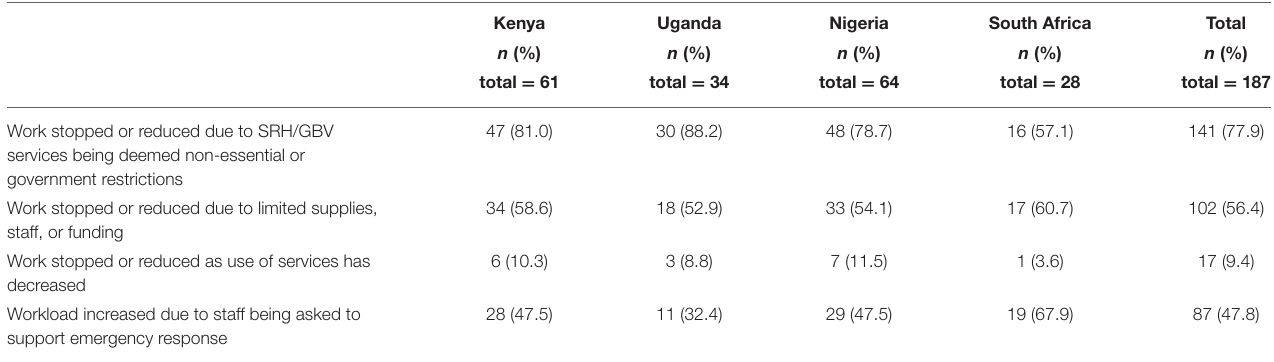
TABLE 2 | Effect of the COVID-19 pandemic on organizational operations.